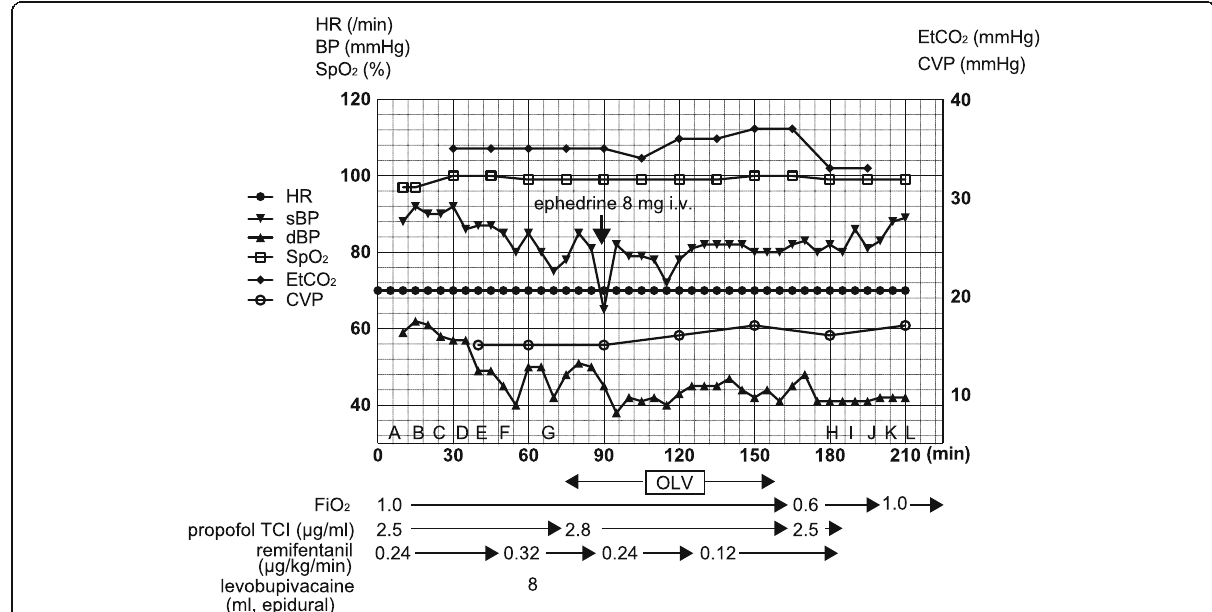
Fig. 3 Intraoperative hemodynamic and respiratory changes during the diaphragmatic plication surgery: there was no major hemodynamic deterioration associated with the implementation of one-lung ventilation (OLV). a Epidural catheter placement, b start of general anesthesia, c intubation, d central line placement, e TEE insertion, f rt. decubitus position, g start of operation, h end of operation, i supine position, j TEE removal, k extubation, and l end of anesthesia